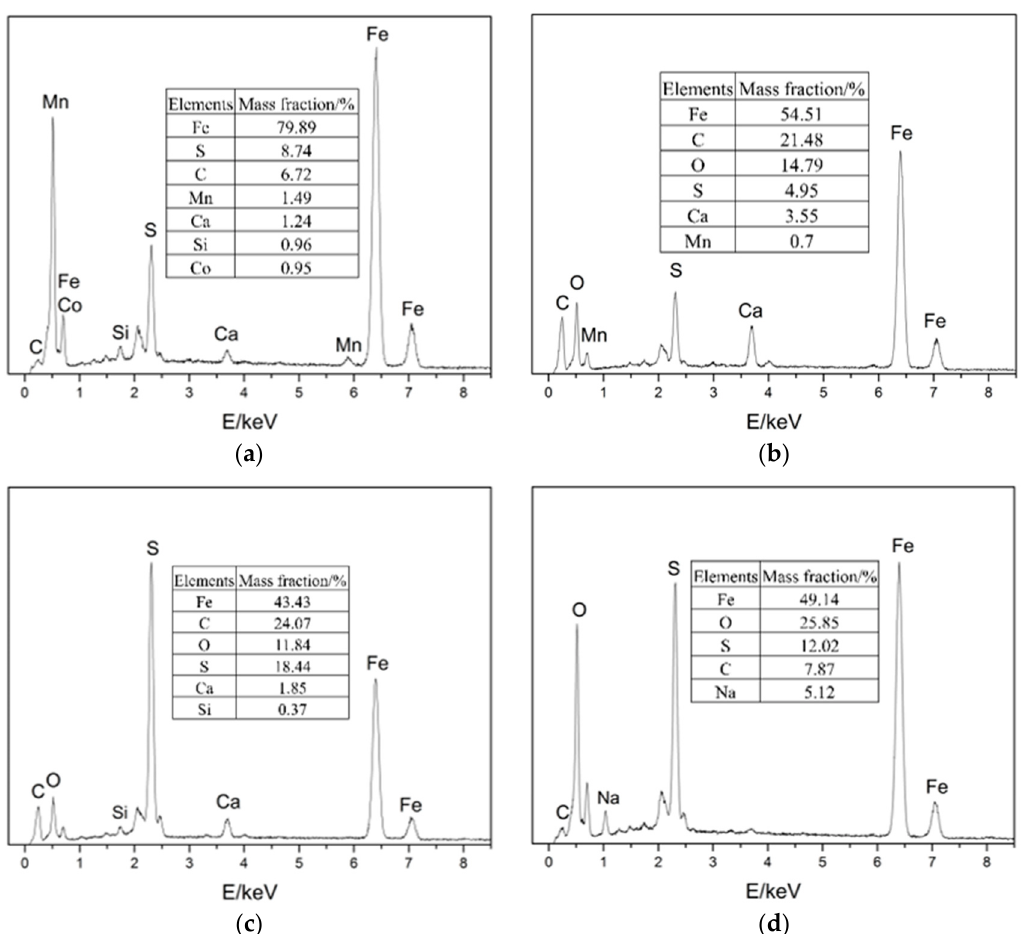
Figure 7. EDS images of the samples: ( a ) location 1; ( b ) location 2; ( c ) location 3; ( d ) location 4.